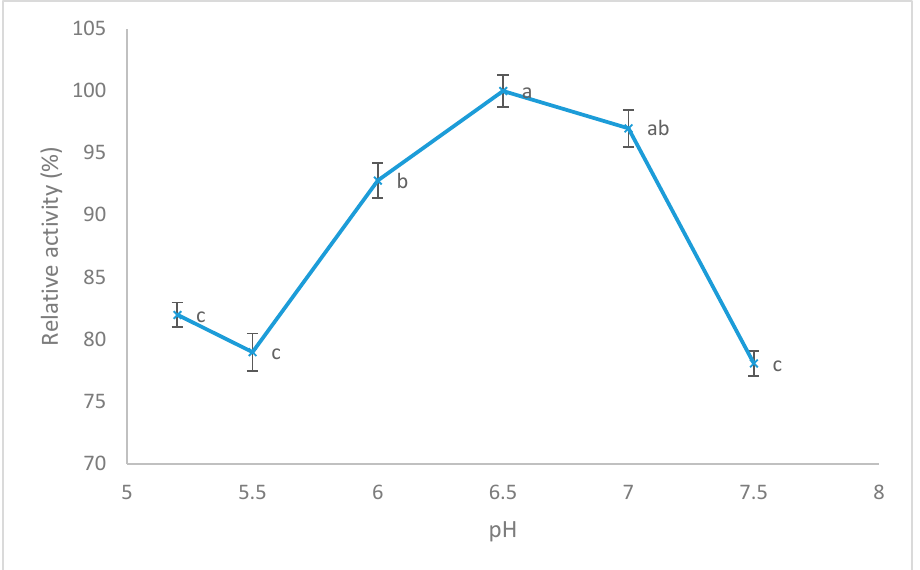
Figure 6. Effect of different pHs on proteolytic activity (PA) of aqueous extract from ripe pulp kiwifruit. The percentage (%) of relative PA represents the mean of three independent determinations performed in triplicate. The maximum value of PA was 100%. Error bars represent standard deviations. Different lowercase letters (a, b and c) indicate a significant difference among samples at p < 0.05 (ANOVA with Tukey’s post hoc test). Table 2. Effect of pH on MCA/PA ratio at 40 °C. MCA was expressed in SU/mL and PA was expressed in U.